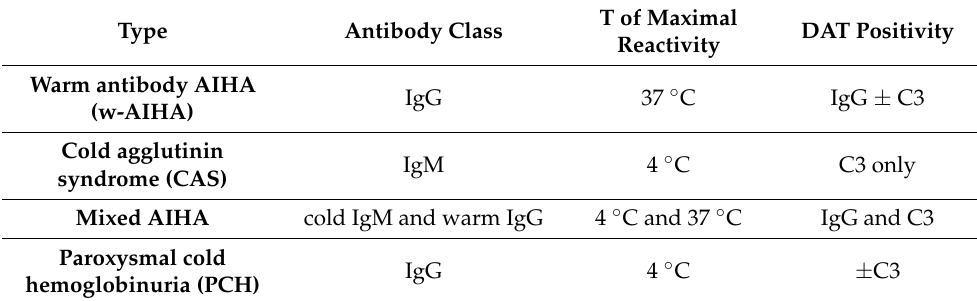
Table 1. Classification of autoimmune hemolytic anemia